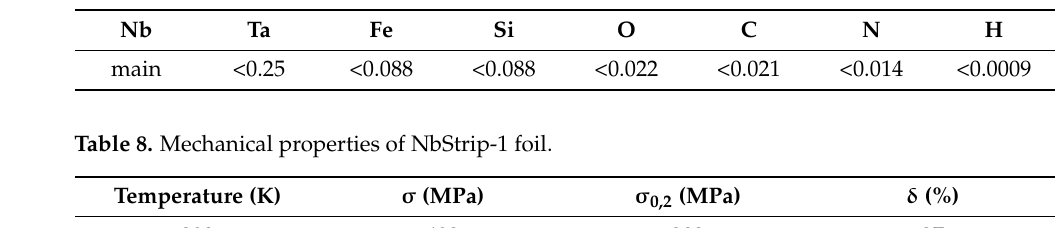
Table 7. Chemical composition of NbStrip-1 foil in %.